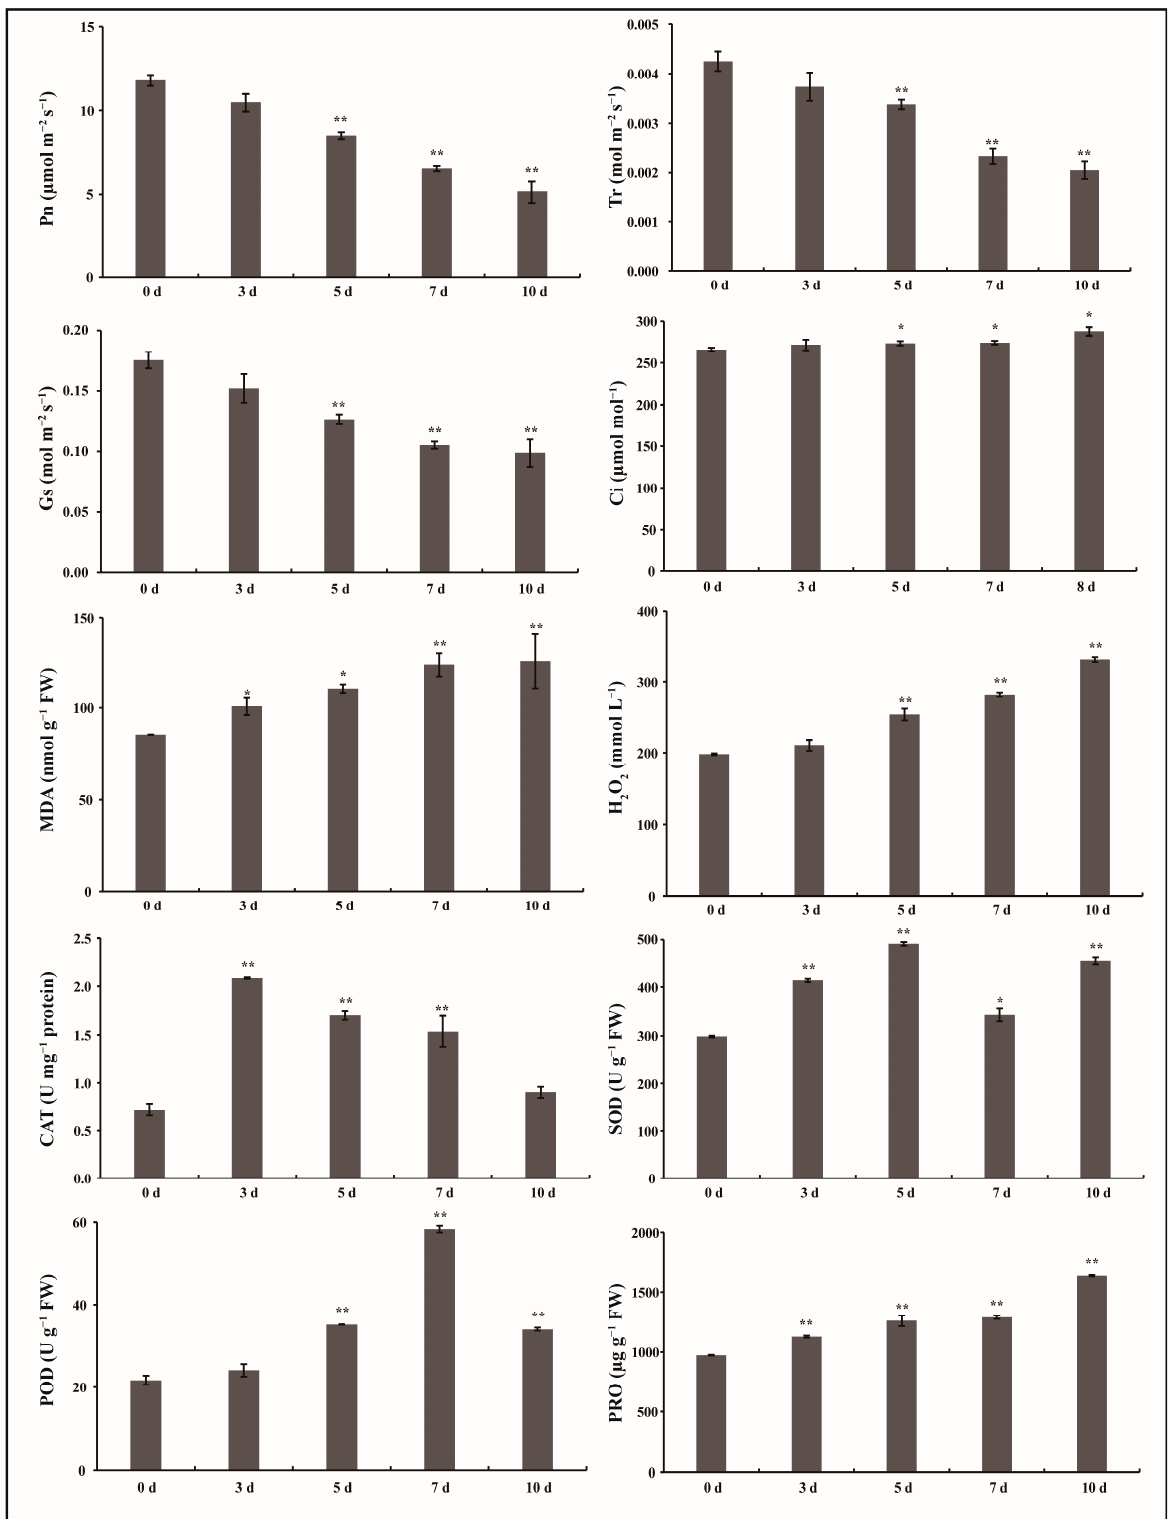
Figure 2. Physiological and biochemical evaluation of G. anomalum seedlings in response to drought treatment. Pn: net photosynthetic rate, Tr: transpiration rate, Gs: stomatal conductance, Ci: intercel- lular CO 2 concentration, MDA: malondialdehyde, H 2 O 2 : hydrogen peroxide, CAT: catalase, SOD: superoxide dismutase, POD: peroxidase, PRO: proline. * p < 0.05, ** p < 0.01, Student’s t test.